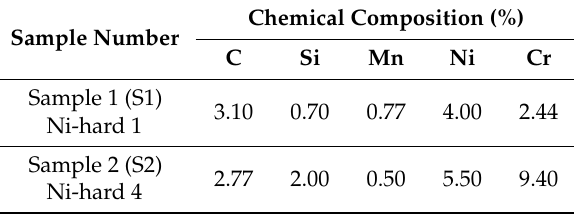
Table 1. Chemical composition of the Ni-hard alloys